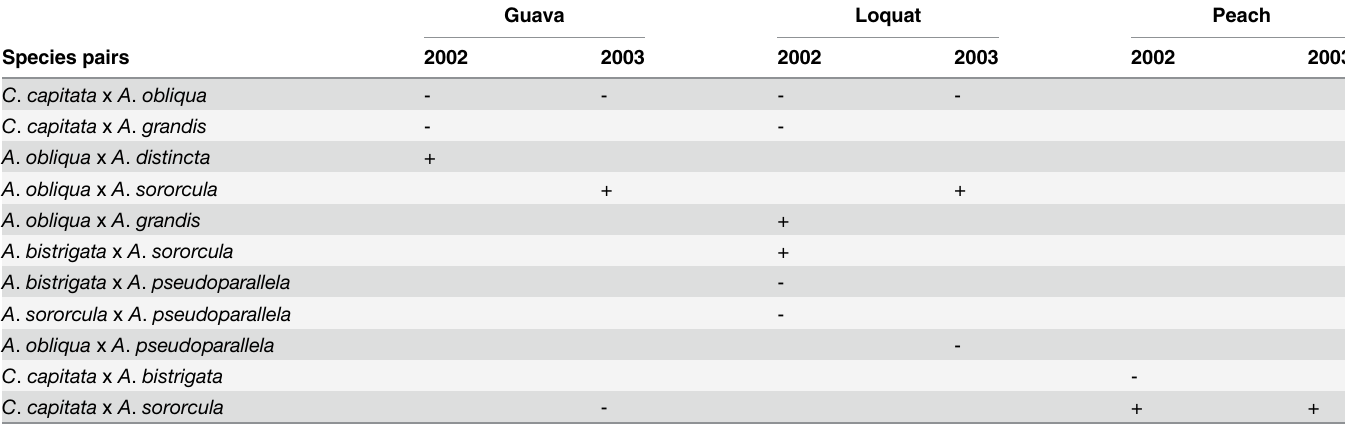
Table 4. Significantly aggregated and segregated species detected in species co-occurrence analysis.